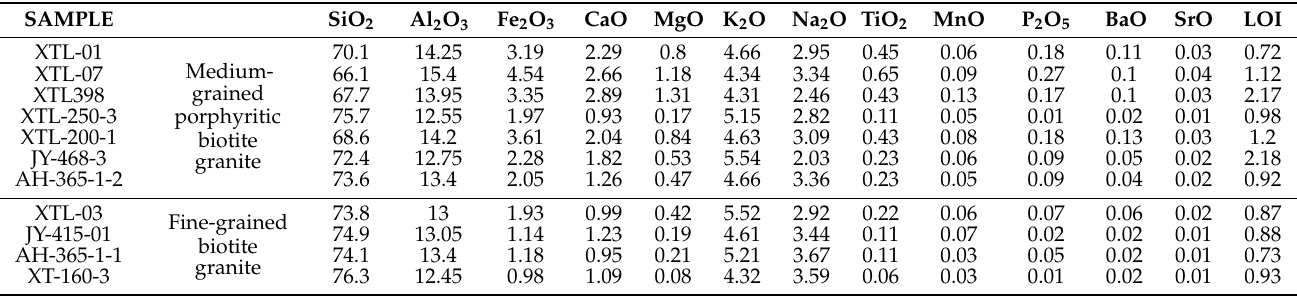
Figure 3. Sketch geological map of the Xintianling deposit (Zhang et al., 2015) [8]. Table 1. Main elements of granite in Xintianling ore field, Hunan (wt%).